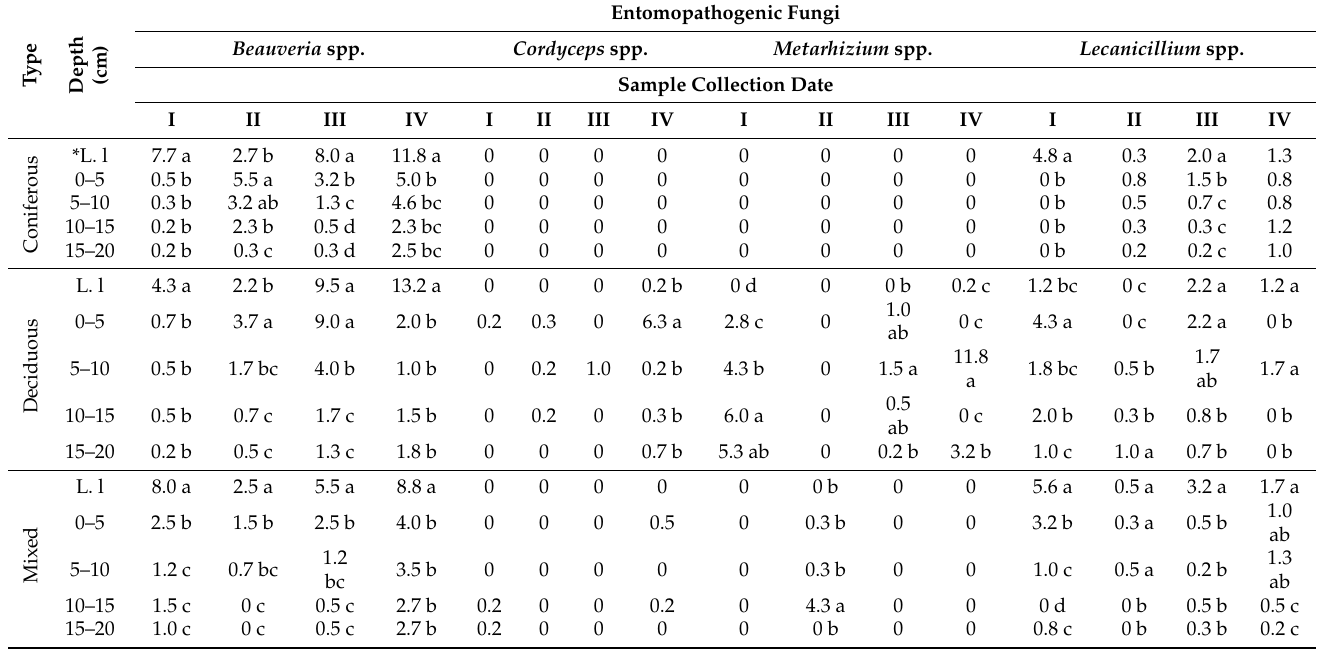
Table 2. Mean densities of entomopathogenic fungi (CFUs × 10 3 /g soil or leaf litter) in the Chod ó w locality; lowercase letters represent statistically significant differences between CFUs among the sampling depths (leaf litter vs. other layers) at each sampling date and forest